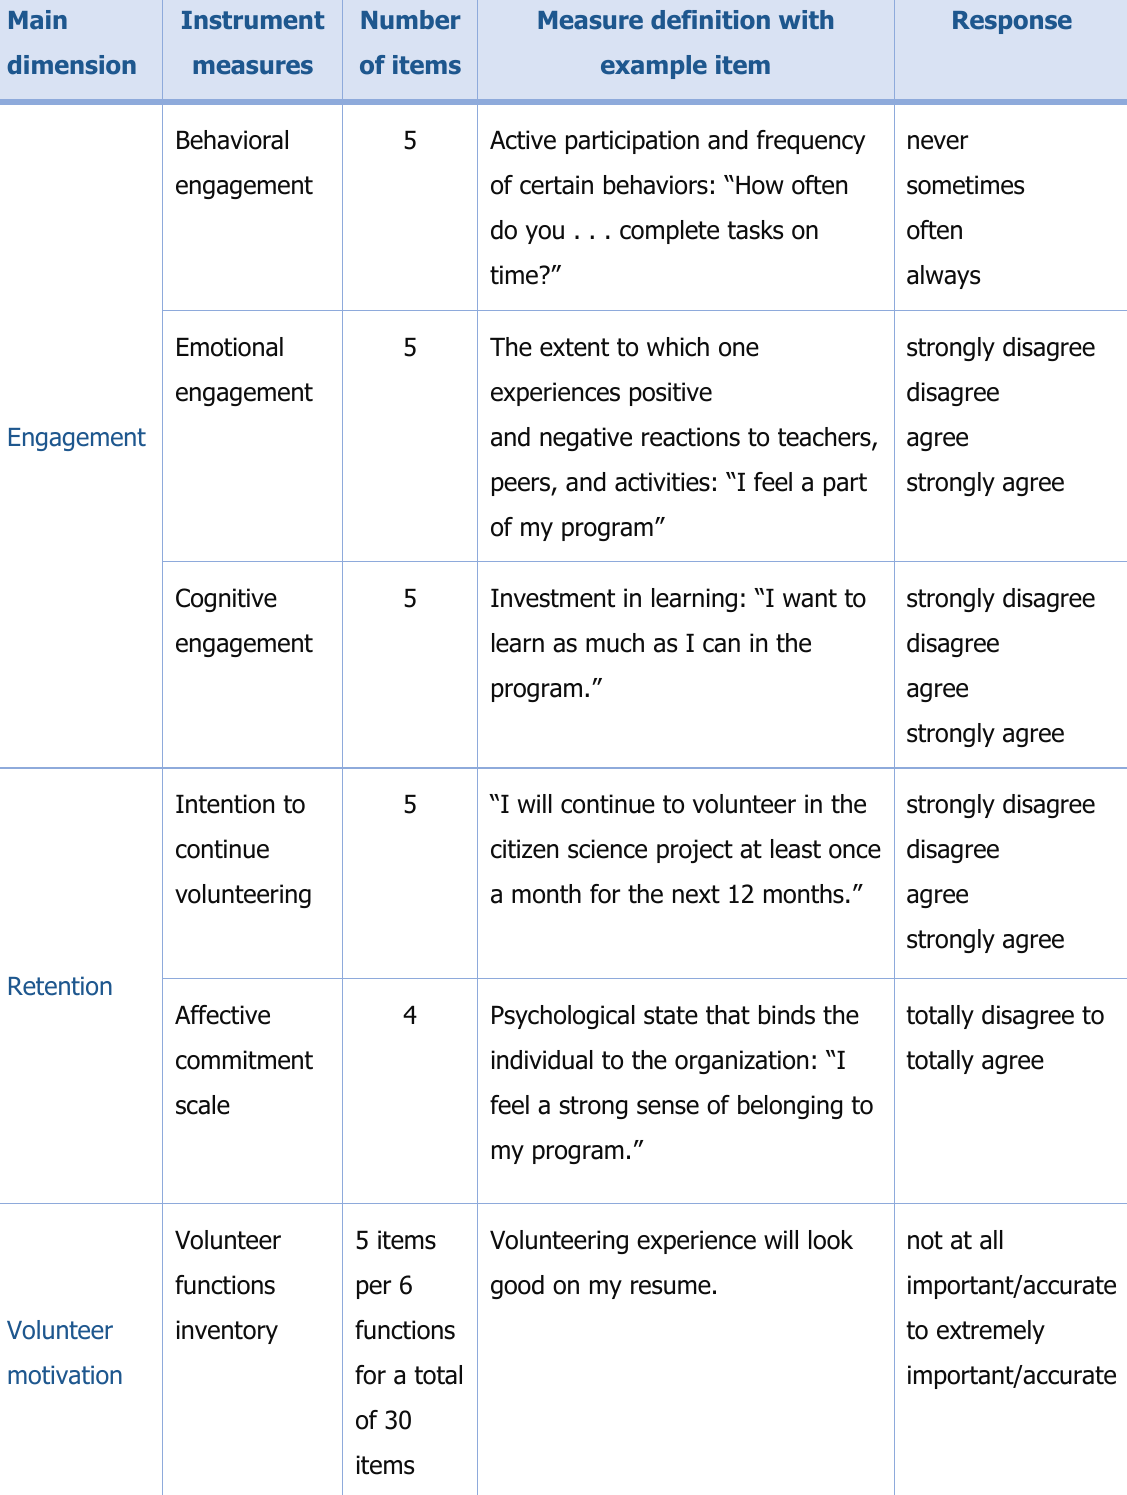
Table 1. Instrument Engagement, Retention, and Motivation Measures Main